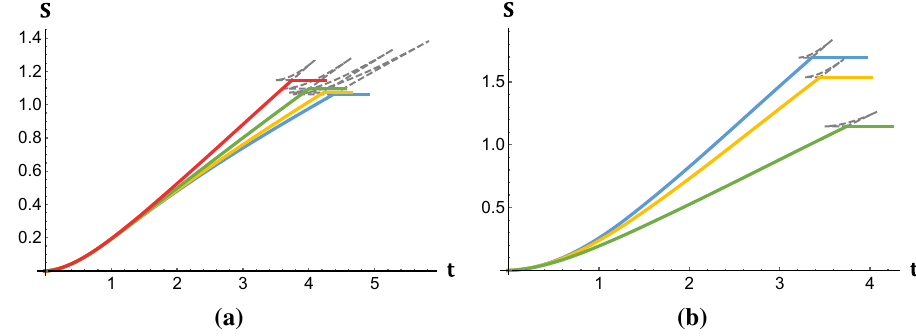
Fig. 2 The left plot is for the evolution of HEE with various values of b , where the blue, yellow, green and red lines correspond to b = 0, 1 , 1, 2, respectively. The charge and the width of the strip are fixed as 2 Fig. 3 The dependence of the holographic subregion complexity on the parameter b with l = 5 (the left plot) and l = 1 (the right plot). The blue, yellow, green and red lines correspond to b = 0, 1 , 1, and 2 2 respectively, with a fixed charge Q = 0 .